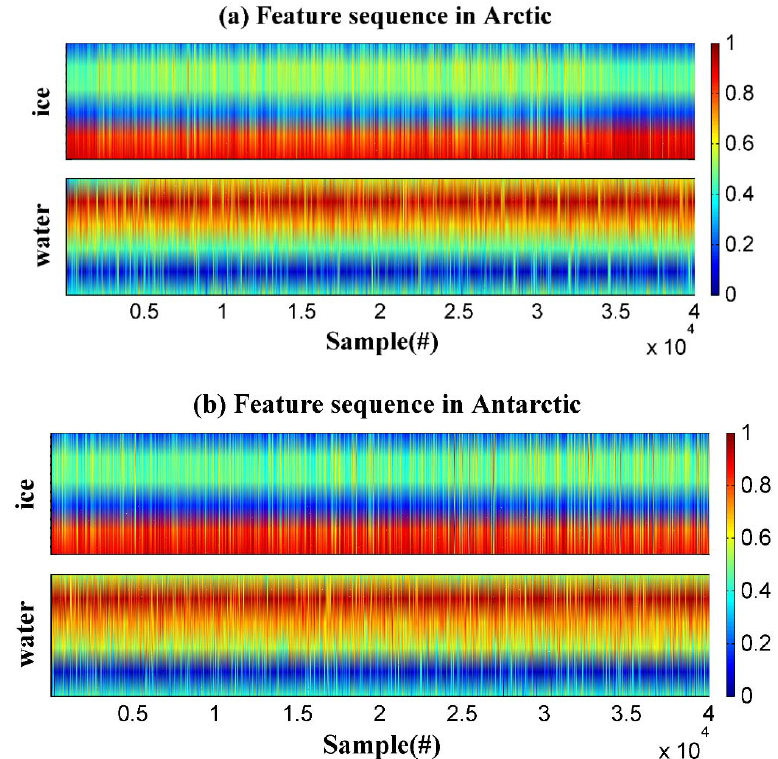
Figure 7. Feature sequences composited with RESC, RESI, RESD, REWC, REWI and REWD in ( a ) Arctic ( b ) and Antarctic regions. The upper plot in each figure represents the feature sequences of sea ice and the lower plot represents those of sea water. The color scale represents the value of each feature parameter.